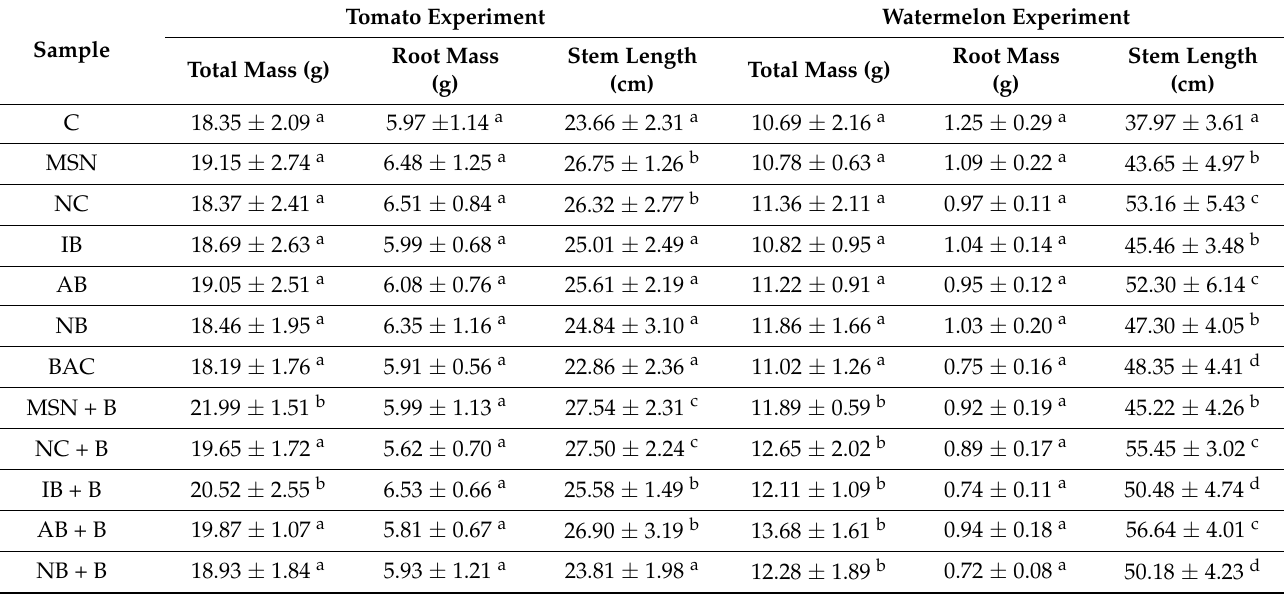
Table 4. Biomass measurements in 2nd tomato and watermelon